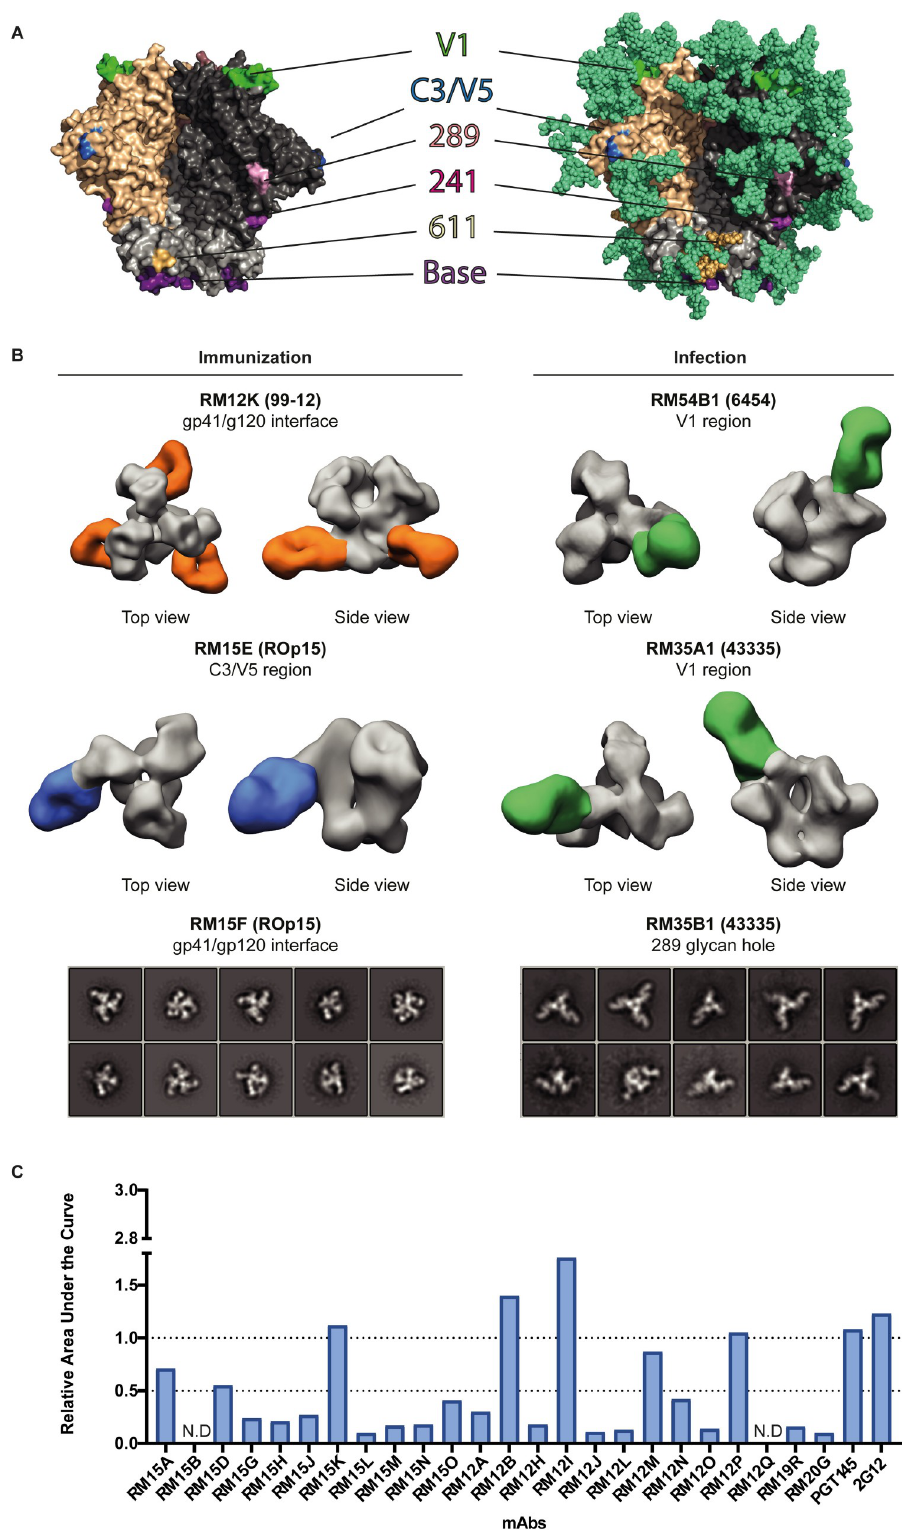
Fig 3. Epitope mapping of mAbs isolated from BG505 SOSIP-immunized and BG505 SHIV-infected NHPs. (A) Model of BG505 SOSIP without (left) and with (right) glycans. The different epitopes targeted by mAbs induced